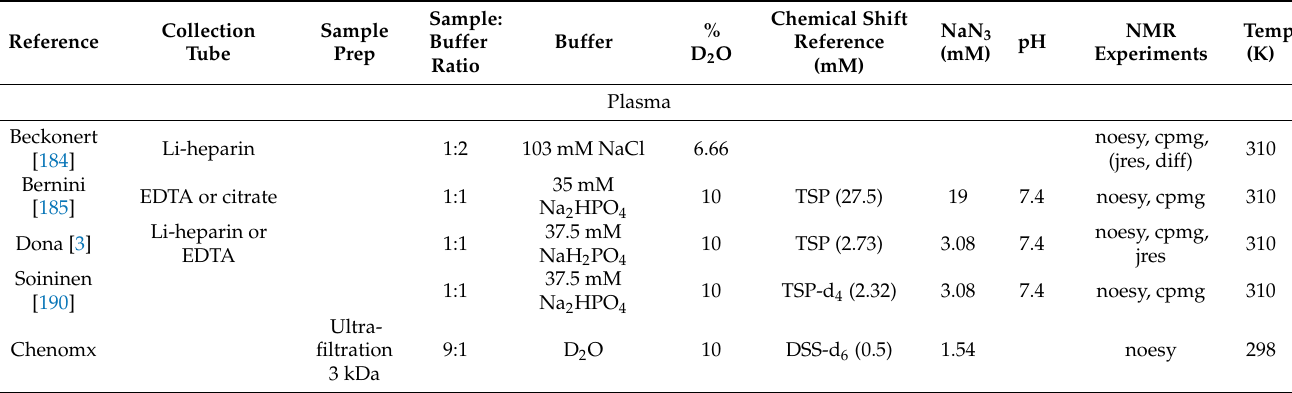
Table 1. Comparison of the final buffer concentrations and pulse sequence combinations for serum/plasma and